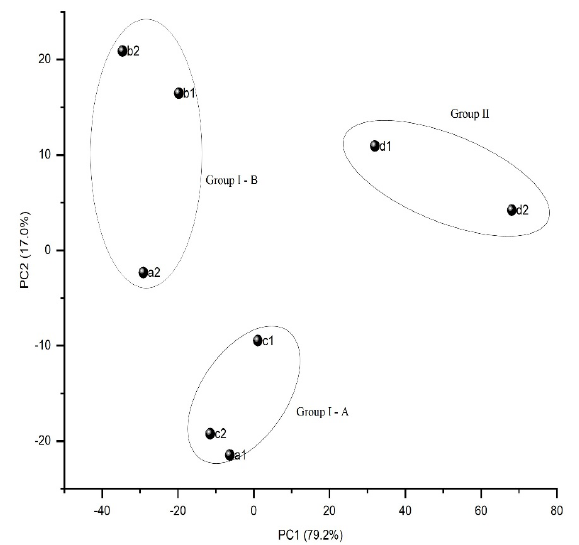
Figure 6: 2-dimensional score plot in the plane of PC1 x